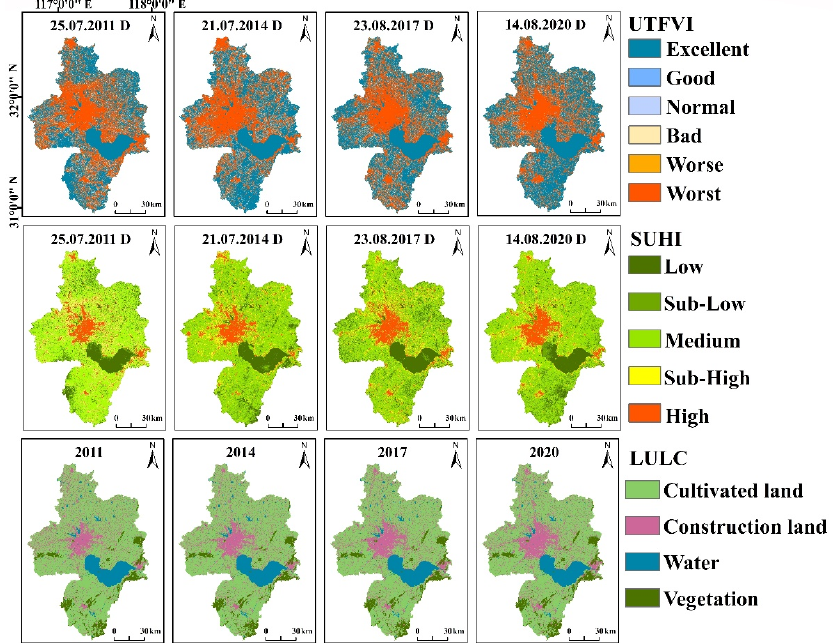
Figure 10. Images of UTFVI, SUHI, and LULC for 2011, 2014, 2017, and 2020. Table 4. The area percentage of UTFVI of each MFOZ from 2011 to 2020.